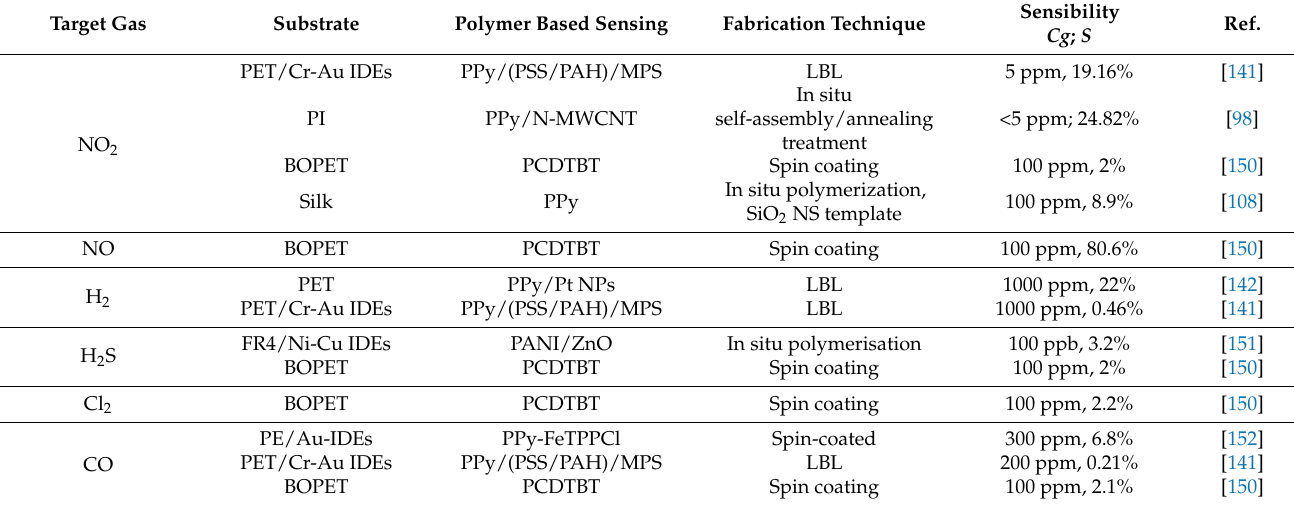
Table 3. Flexible gas sensors aside from